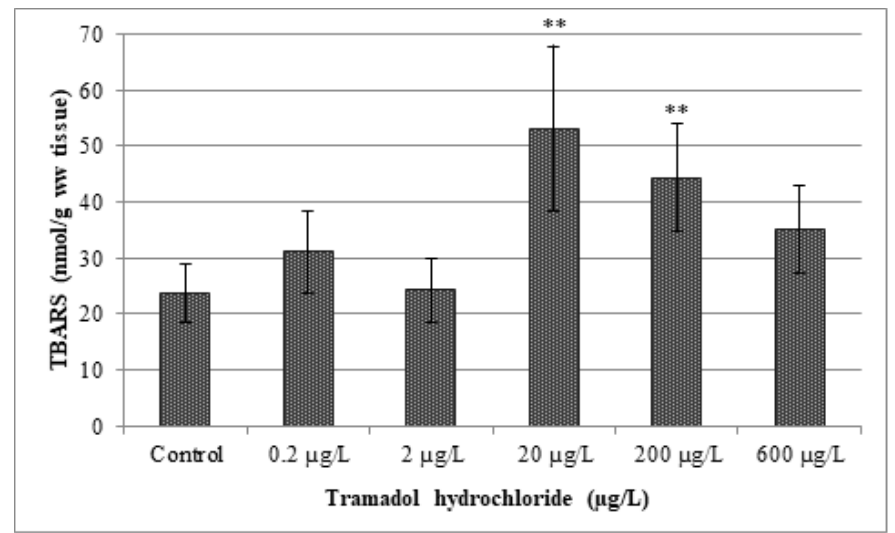
Figure 6. Analysis of thiobarbituric acid reactive substance levels (TBARS). Data are expressed as mean ± standard deviation. Significant differences between control and experimental groups are indicated by ** ( p < 0.01).